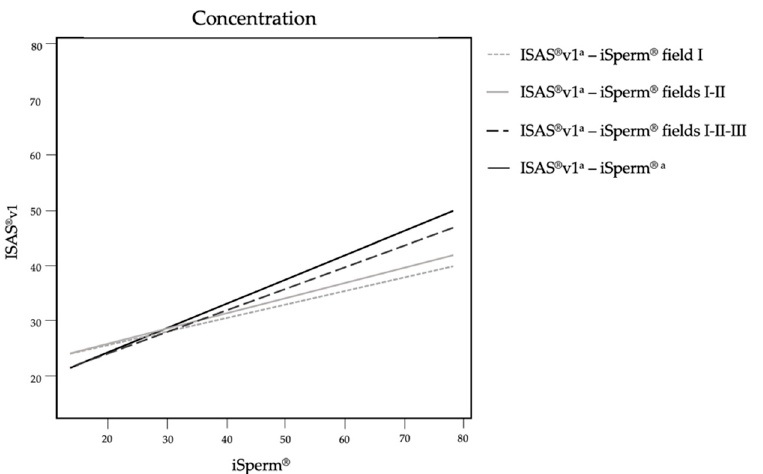
Figure 2. Correlation trends concerning the estimation of semen concentration on ISAS ® v1 and iSperm ® . The four lines resulted from the comparison of the average of the four fields analyzed by ISAS ® v1 and different number of fields analyzed by iSperm ® (one, two, three or four fields). a Average of four frames.